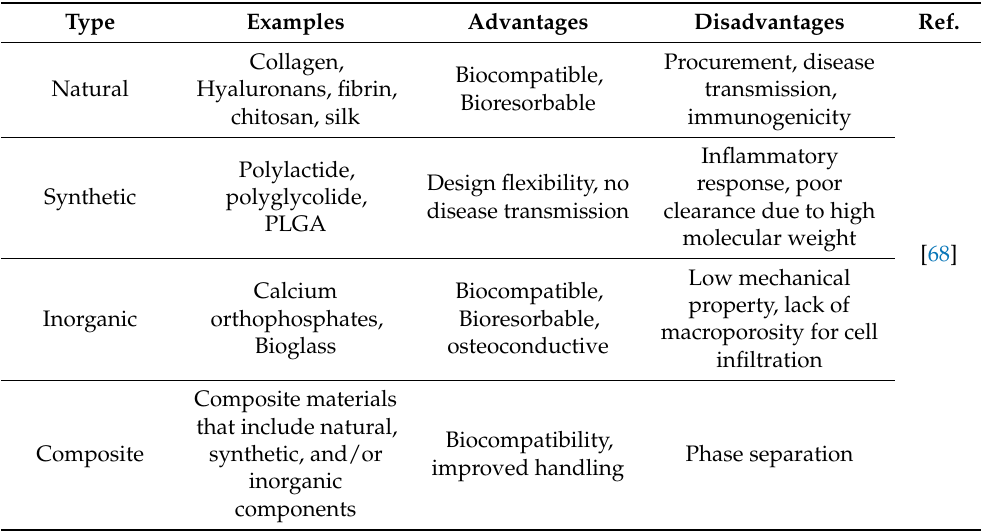
Table 4. Common types of carrier materials for delivery of bone morphogenetic